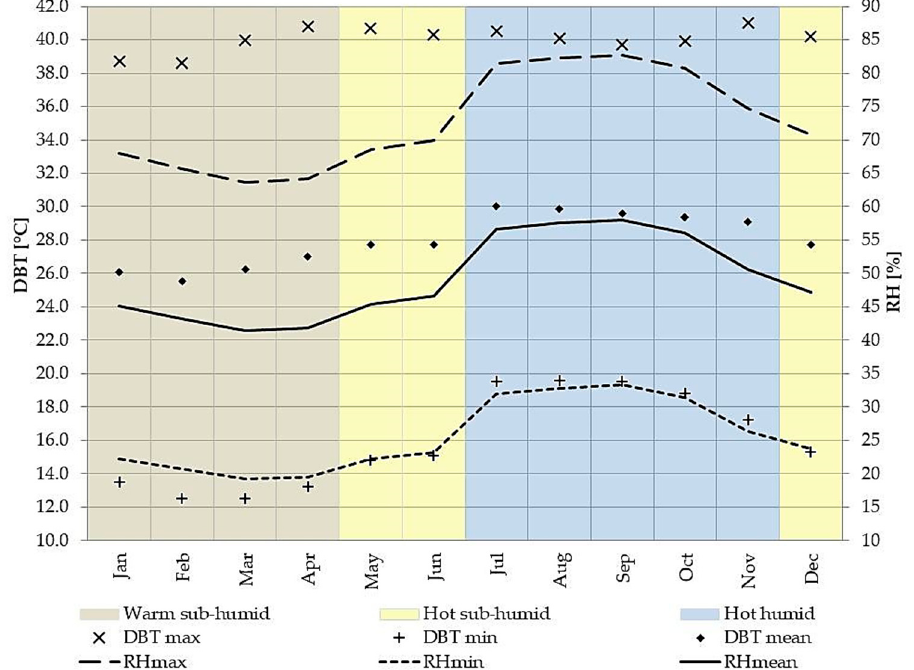
Figure 2. Monthly dry bulb temperature and relative humidity for Coquimatlan, Mexico.